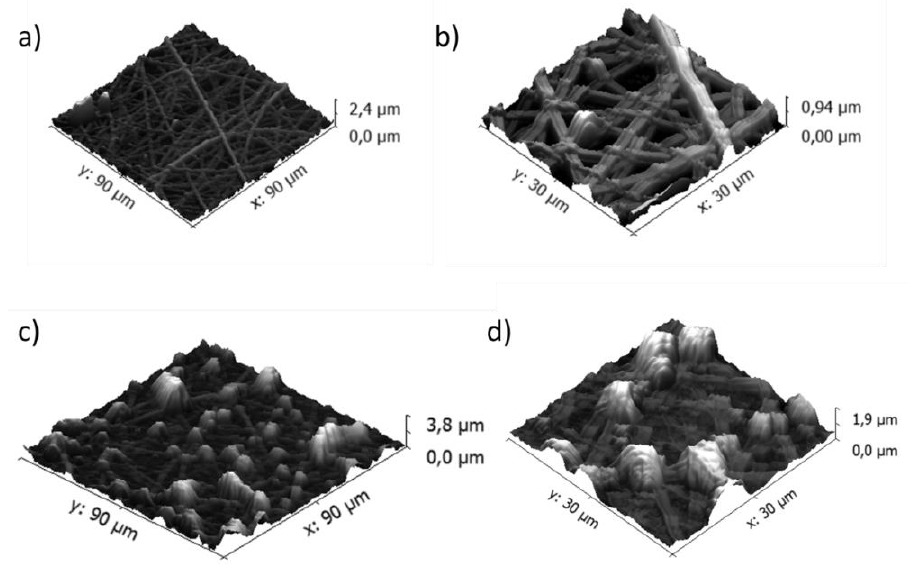
Figure 8. ( a , b ) The 3D-AFM images of as electrospun fibers of PAA + β-CD + TiO 2 NPs (previous CVD-silanization) for a dimension range of 90 µm × 90 µm and 30 µm × 30 µm, respectively; ( c , d ) 3D-AFM images after the CVD-silanization process of the electrospun fibers for a dimension range of 90 µm × 90 µm and 30 µm × 30 µm, respectively.